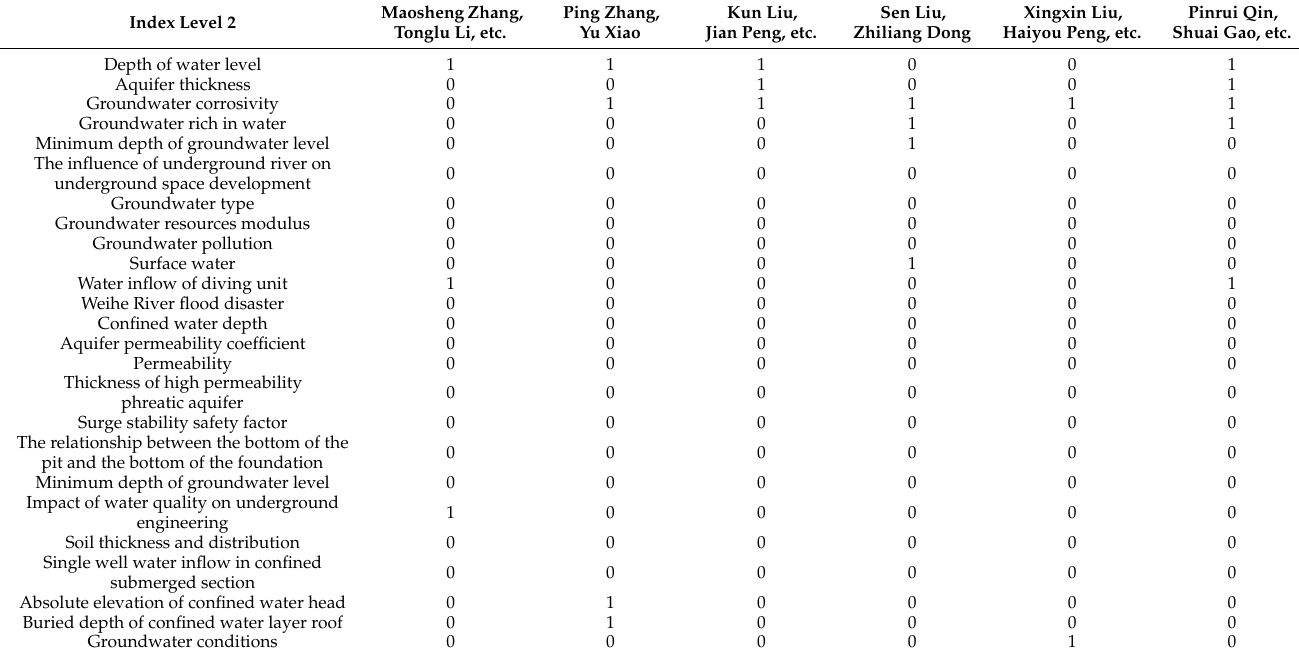
Table A9. Second level index binarization